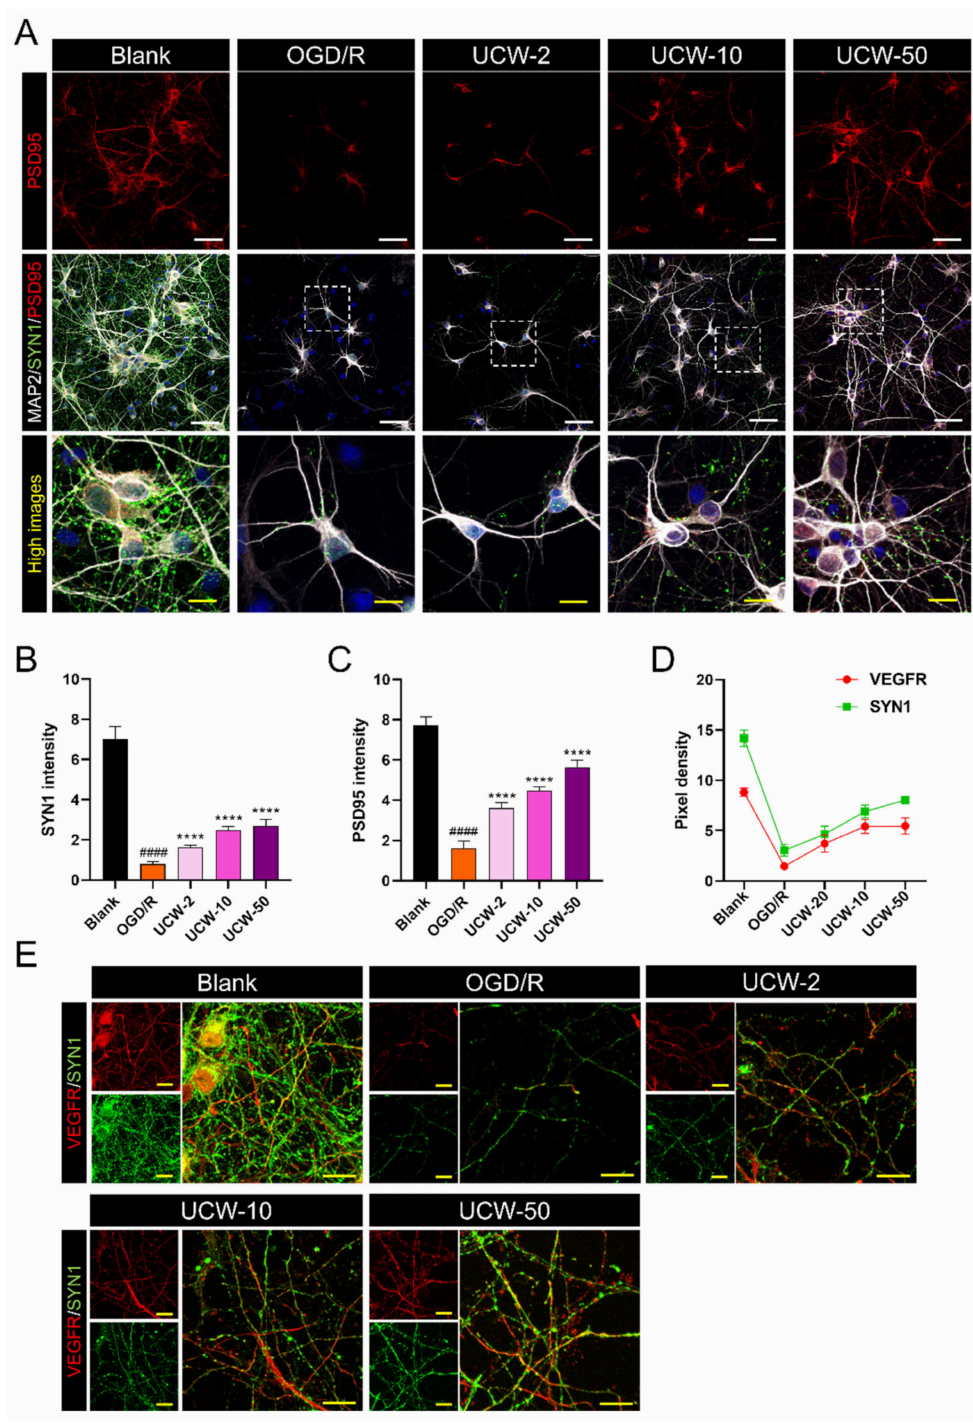
Figure 6. Preventing synaptic loss of UCW on OGD/R-injured neurons by upregulating synaptic proteins. ( A ) Representative images of immunocytochemistry for MAP2 (white), SYN1 (green), and PSD95 (red) in blank, OGD/R injury, UCW + OGD/R injury. White scale bar = 100 µ m, yellow scale bar = 10 µ m. ( B , C ) Quantitative analysis of ( B ) SYN1 and ( C ) PSD95 intensities in each group ( n = 10). ( D ) Quantitative analysis of VEGF + or SYN1 + pixel density in each group ( n = 10). ( E ) Representative images of immunocytochemistry for VEGFR (red) and SYN1 (green) in each group. Yellow scale bar = 10 µ m. Data are expressed as the mean ± SEM. Significant differences were analyzed via ordinary ANOVA with Tukey’s post-hoc analysis as follows: #### p < 0.0001 vs. blank group; **** p < 0.0001 vs. the OGD/R